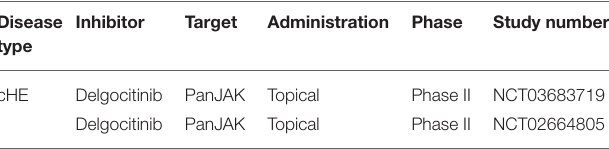
TABLE 11 | Clinical trials of JAKi in chronic hand eczema. cHE, chronic hand eczema according to